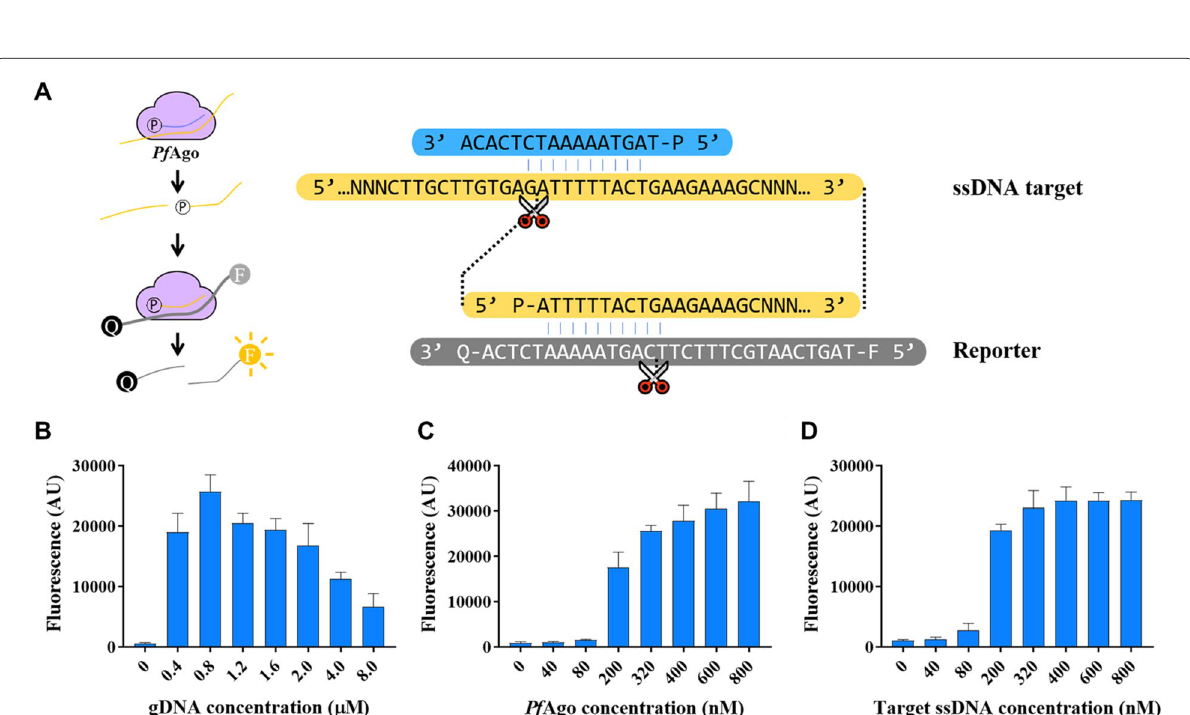
Fig. 2 Optimization of RADAR detection. A Schematic of assay to determine single gDNA-assisted Pf Ago-mediated cleavage activity. B Single gDNA-assisted Pf Ago-mediated cleavage activity with gDNAs of varying concentration when the concentration of Pf Ago is 0.3 µM and that of the target ssDNA is 0.8 µM. C Single gDNA-assisted Pf Ago-mediated cleavage activity of Pf Ago with ssDNA of varying concentration when the concentration of Pf Ago is 0.3 µM and that of the gDNA is 0.8 µM. D Single gDNA-assisted Pf Ago-mediated cleavage activity of Pf Ago with Pf Ago of varying concentration when the concentration of gDNA is 0.8 µM and that of the target ssDNA is 0.8 µM. Each bar represents the mean fluorescence signal from the fluorophore-labeled ssDNA cleavage after 40 min at 95 °C. Error bars represent the mean